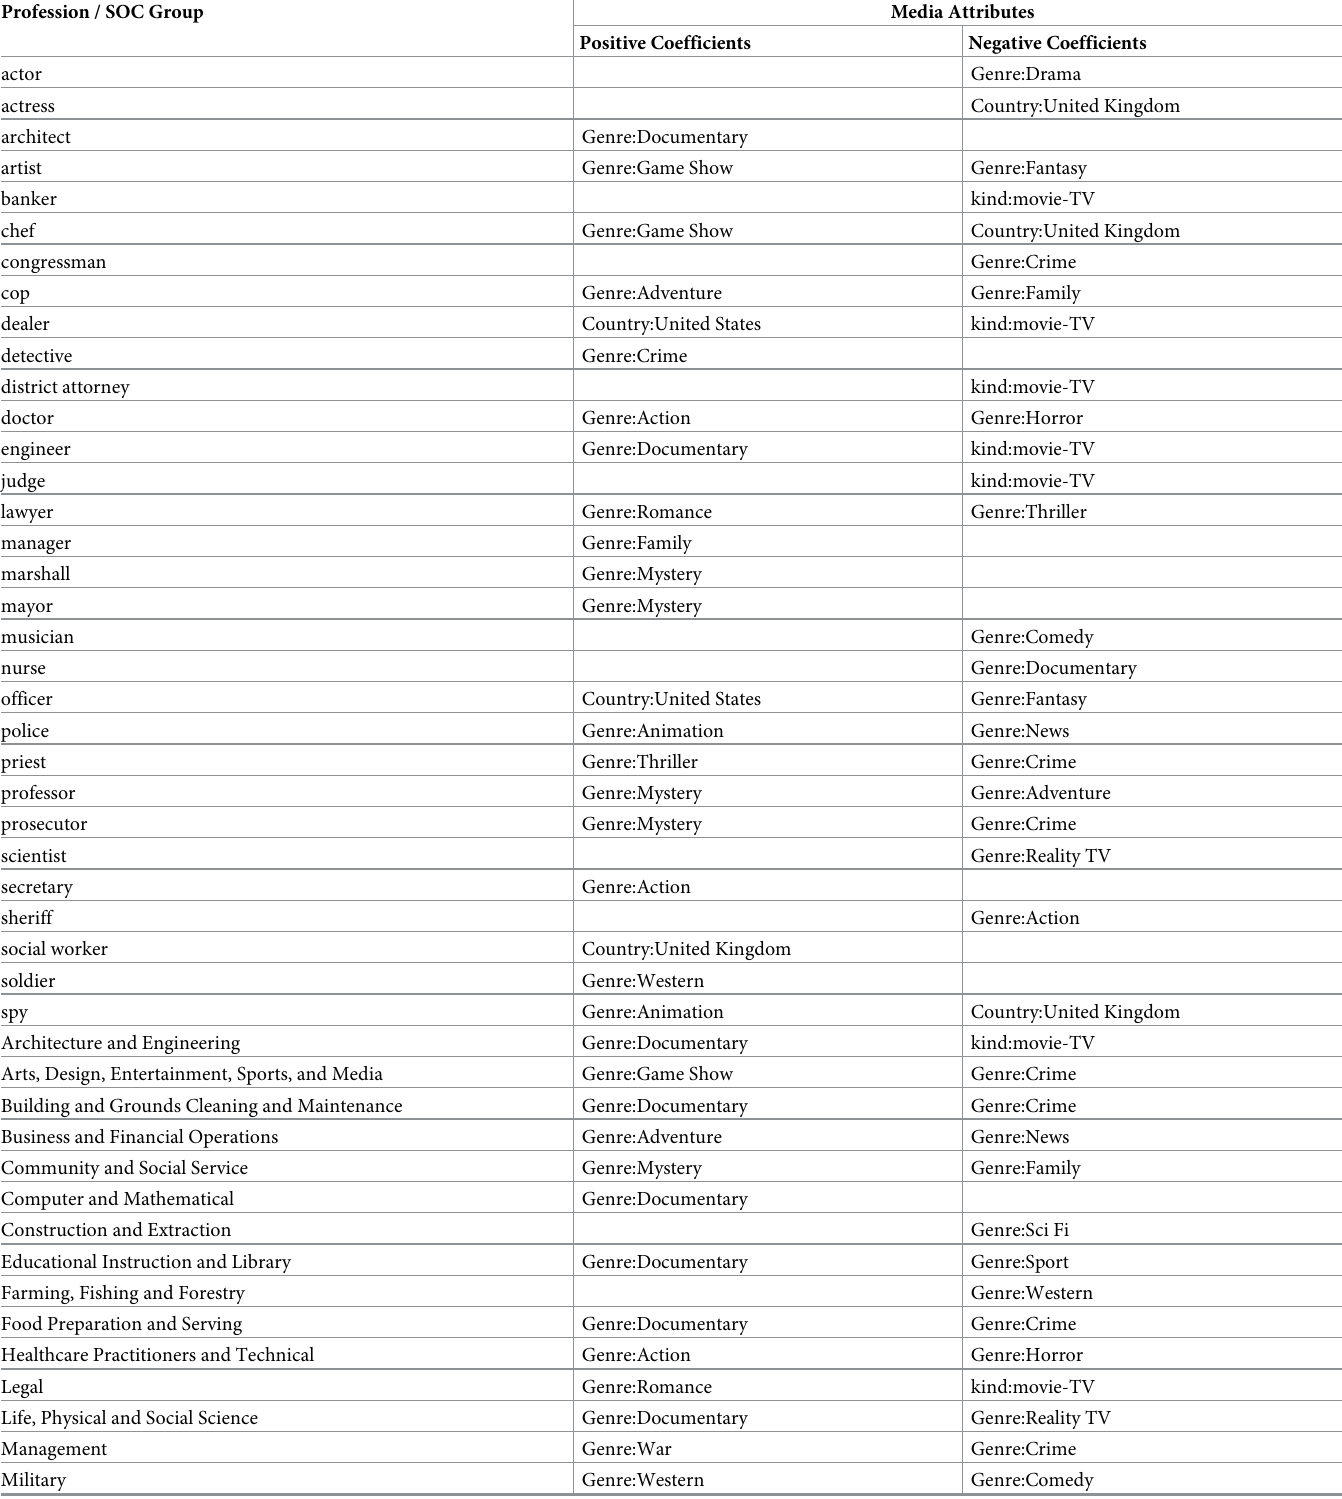
Table 4. Effect of media attributes on the sentiment of professions and SOC